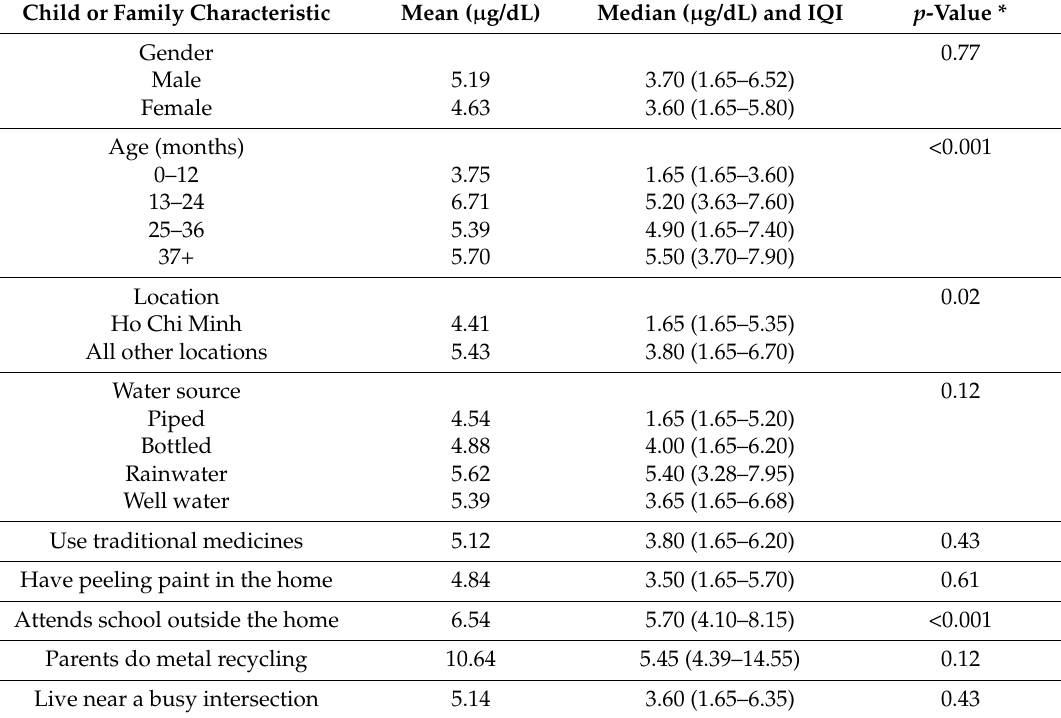
Table 3. BLLs relative to major child and family characteristics ( n =